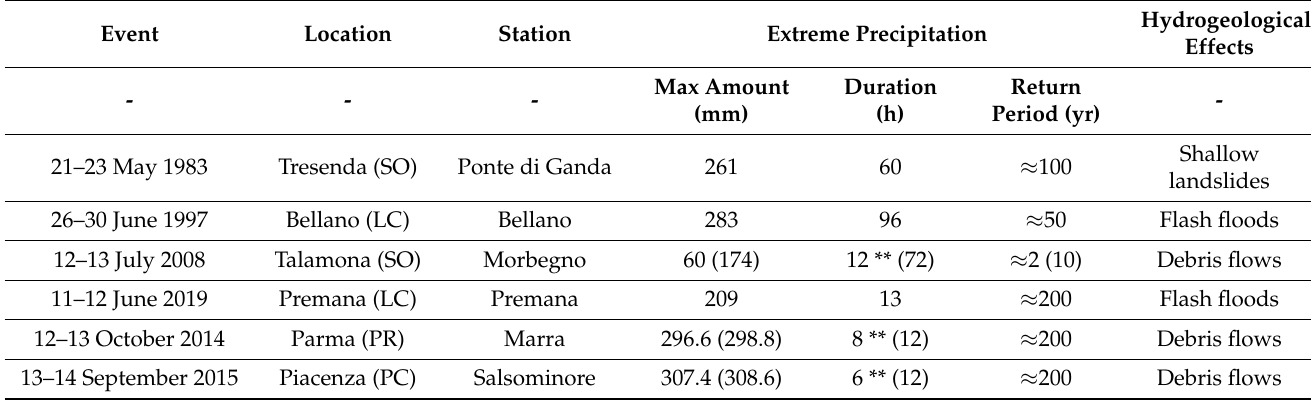
Table 2. Studied events of extreme precipitation. Dates, locations, and extreme precipitation parame- ters that describe the maximum amount, the duration, and the return period, and the hydrogeological effects recorded on the territory. For 2008, 2014, and 2015 events, (**) represents the duration of the most intense phase, while () is the duration of the entire